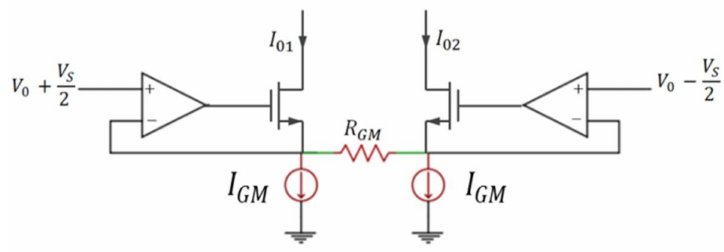
Figure 9. Degenerated transconductance amplifier (OTA) with local feedback.